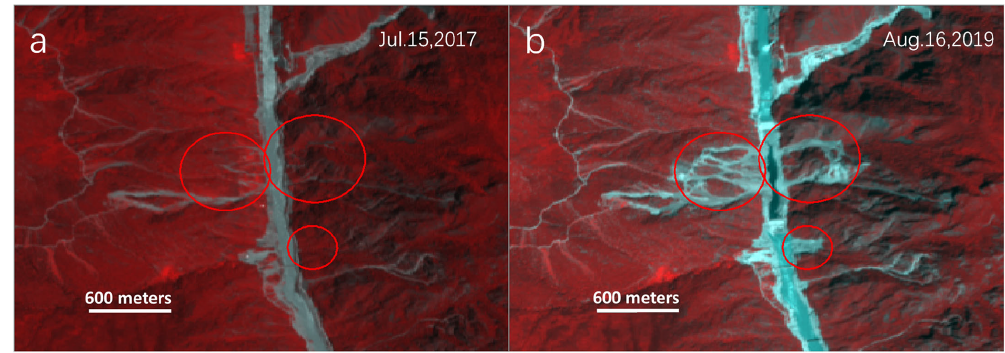
Figure 7. Concurrent landslides related to the Baige floods. False composite Sentinel-2 images were acquired on 15 July 2017 (a) and 16 August 2019 (b) . The spatial extent of this area is shown as rectangle 5 in Fig. 1.